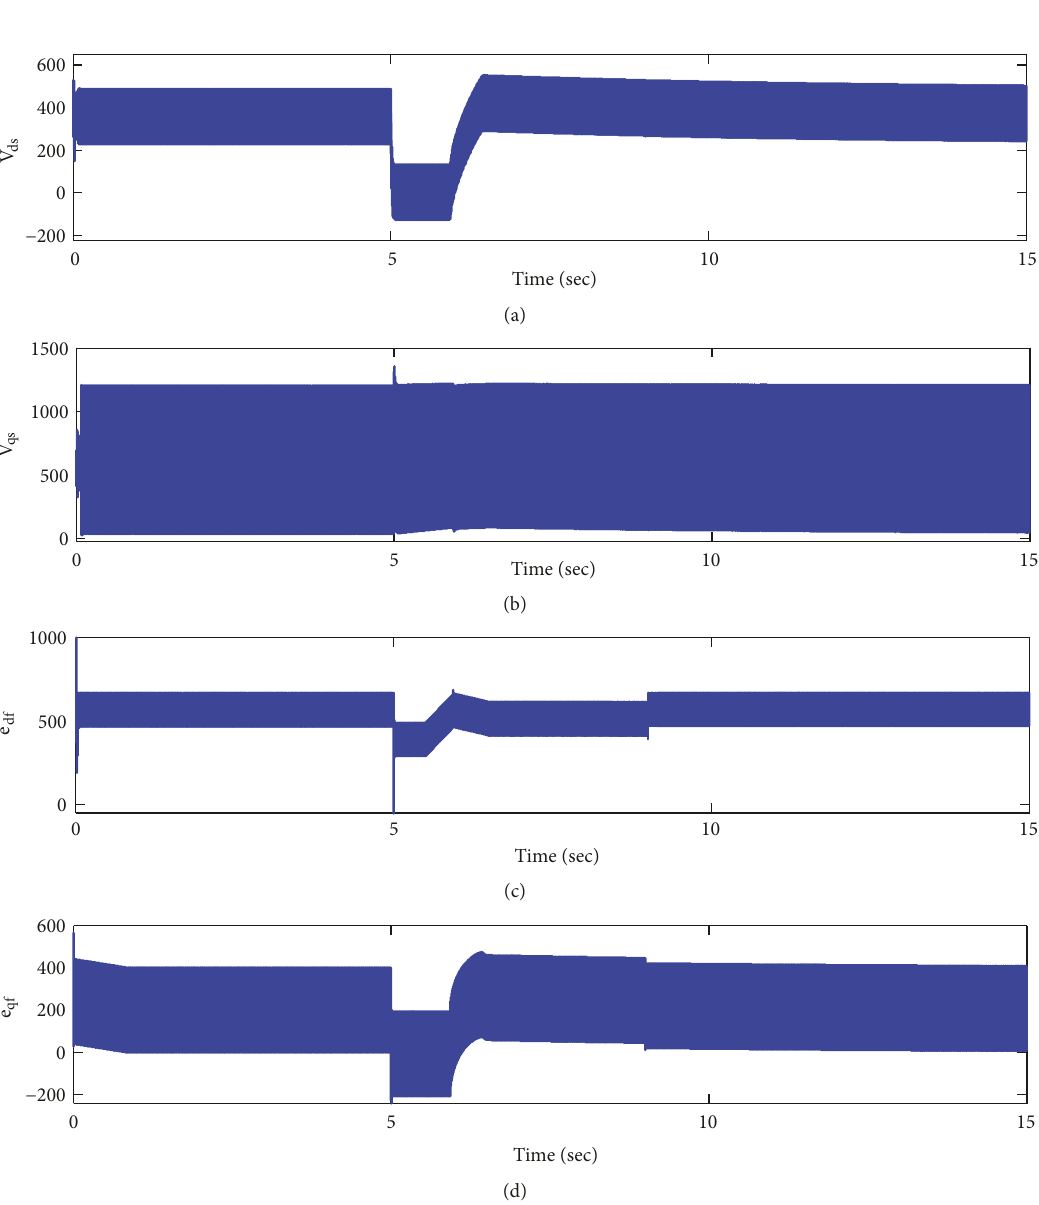
Figure 9: The d-q axis input controller signals for (a) and (b) MSC, (c) and (d) GSC, in